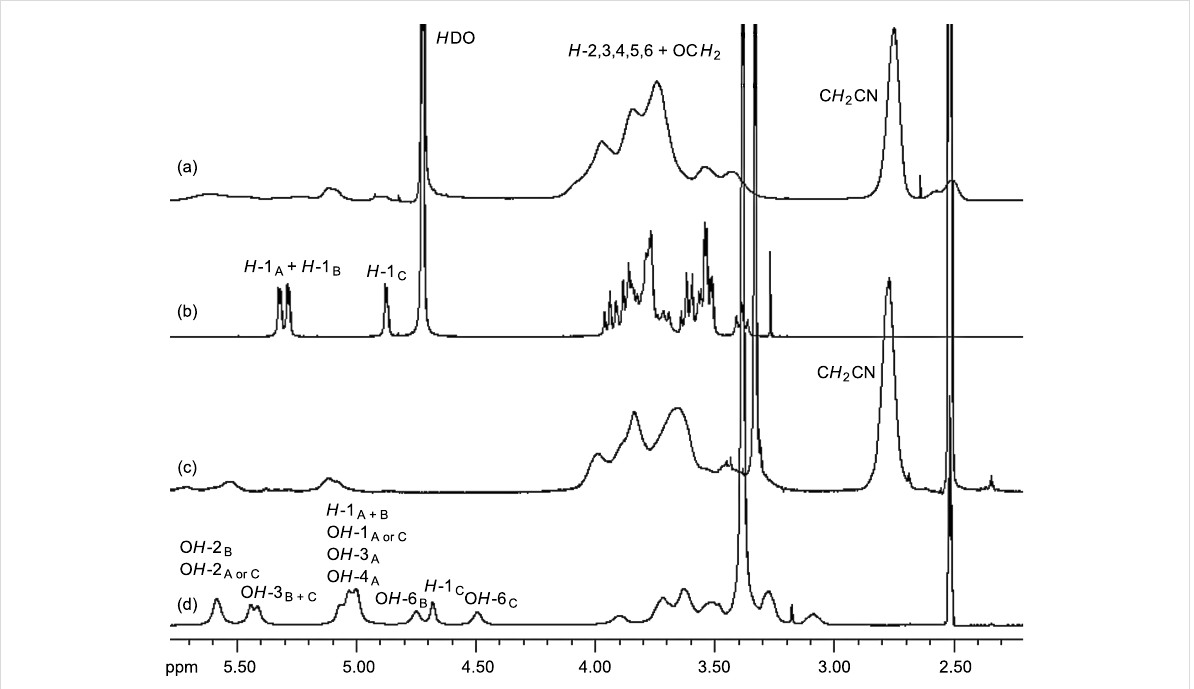
Figure 5: 1 H NMR spectra (400 MHz) of (a) CEP-2 (DS NMR(3) = 1.31) in D 2 O; (b) pullulan, native in D 2 O; (c) CEP-3 (DS NMR(3) = 2.43) in DMSO- d 6 ; (d) pullulan, native in DMSO- d 6 ; calibrated with solvent signals.